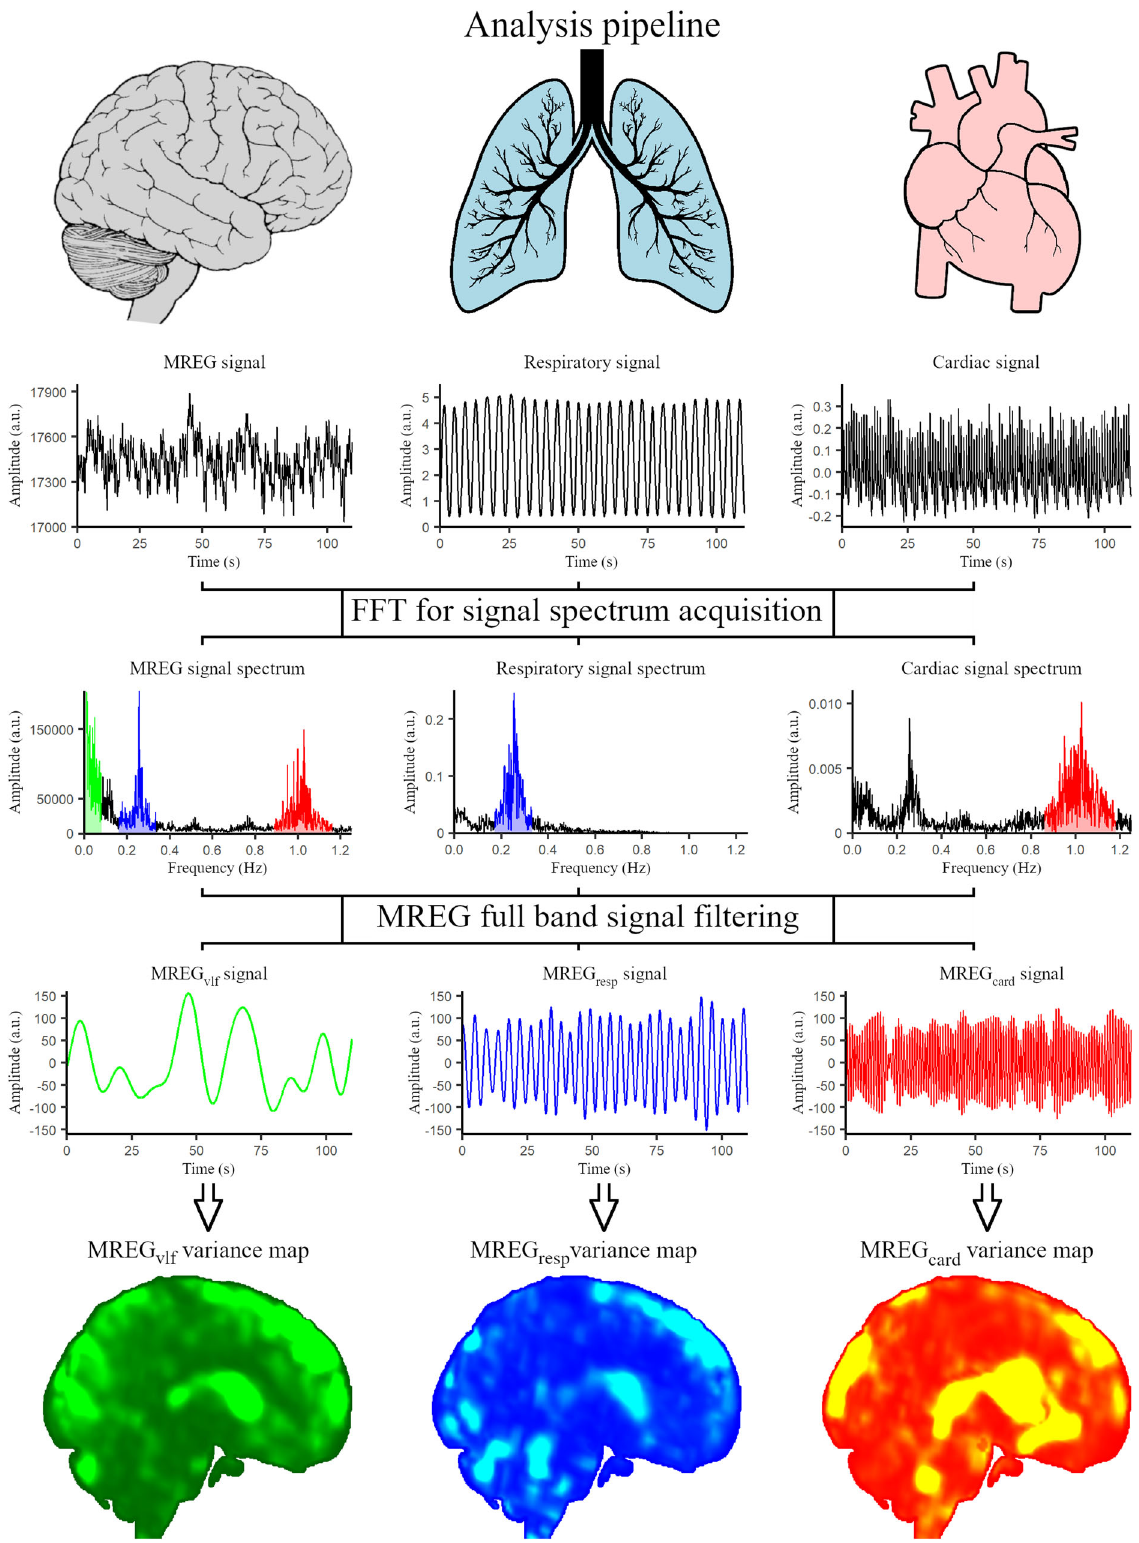
Fig. 1 Analysis pipeline. Temporal magnetic resonance encephalography (MREG), respiratory (end-tidal CO 2 ), and cardiac (photoplethysmogram) signals are transformed into frequency spectra with fast Fourier transformation (FFT). Individual minimum, maximum, and peak values for respiration (blue) and cardiac (red) frequencies are obtained and the cardiorespiratory ranges are calculated. MREG full band signal is fi ltered to these physiological ranges and to very low frequency (green). Voxel-wise variance maps are calculated for each MREG frequency band. MREG vlf very low-frequency fi ltered MREG, MREG resp respiratory frequency fi ltered MREG, MREG card cardiac frequency fi ltered